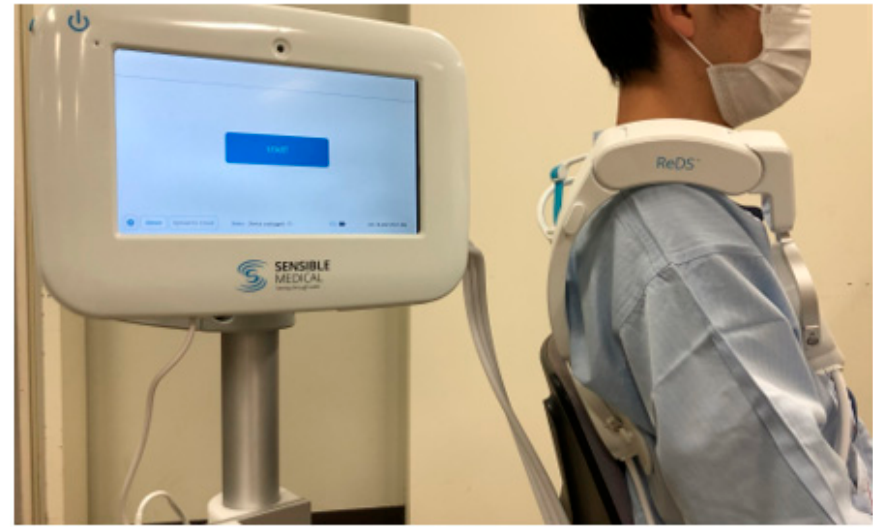
TM ) system with a controller and a sensor.